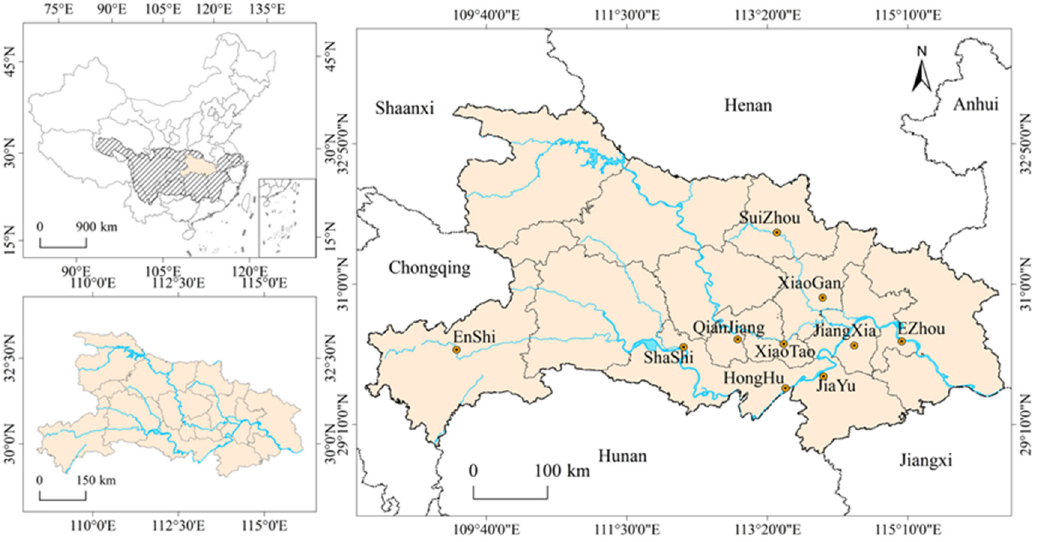
Figure 1. Maps of the province of Hubei indicating the study areas.